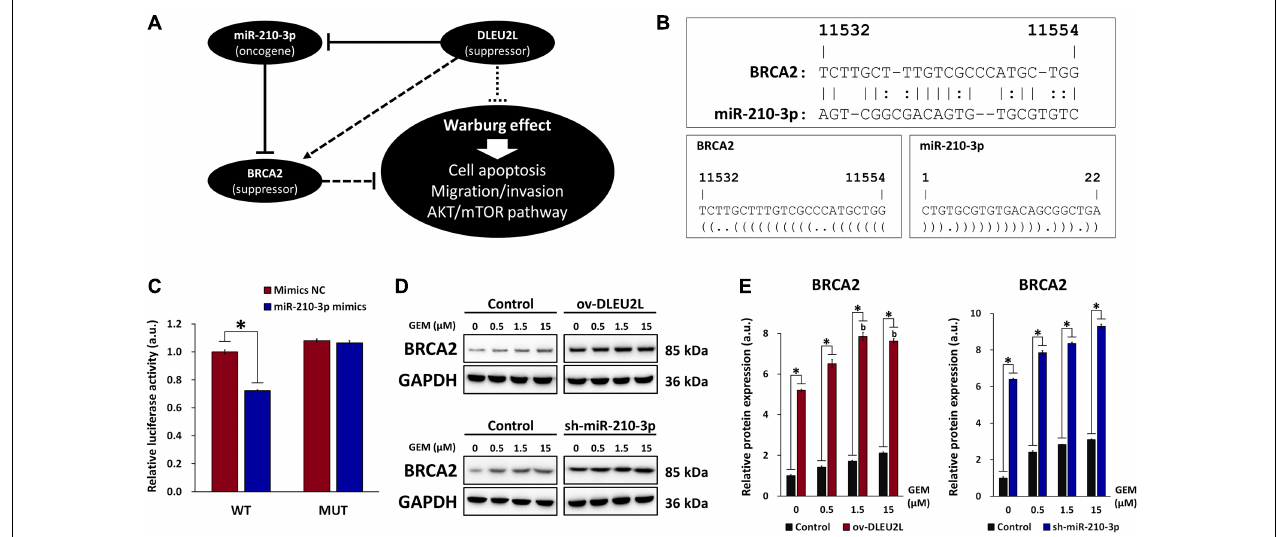
FIGURE 5 | Involvement of BRCA in miR-210-3p sponging and effect on DNA damage repair. (A) Schematic of the proposed ceRNA sponging relationship between DLEU2L, miR-210-3p, and BRCA2 and effect on pancreatic tumor progression. (B) Binding sites between BRCA2 (from position 11532) and miR-210-3p, predicted by RNA22. Dot-bracket notation illustrates binding at specific nucleotides. (C) Dual luciferase activity assay of binding relationship between BRCA2 and miR-210-3p, using miR-210-3p mimics or negative control (NC). Relative luciferase activity represents the ratio of firefly luciferase to renilla luciferase. (D) Western blot of the expression of BRCA2 in PANC-1 cells transfected with DLEU2L overexpression (ov-DLEU2L) or miR-210-3p interference (sh-miR-210-3p) vectors. (E) Quantification of the band gray values in (D) . All numerical data are expressed as the mean ± SD ( n = 3); ∗ p < 0.05; data with the same letters are not significantly different ( p > 0.05) in each plot of western blot. Statistical analysis was carried out using